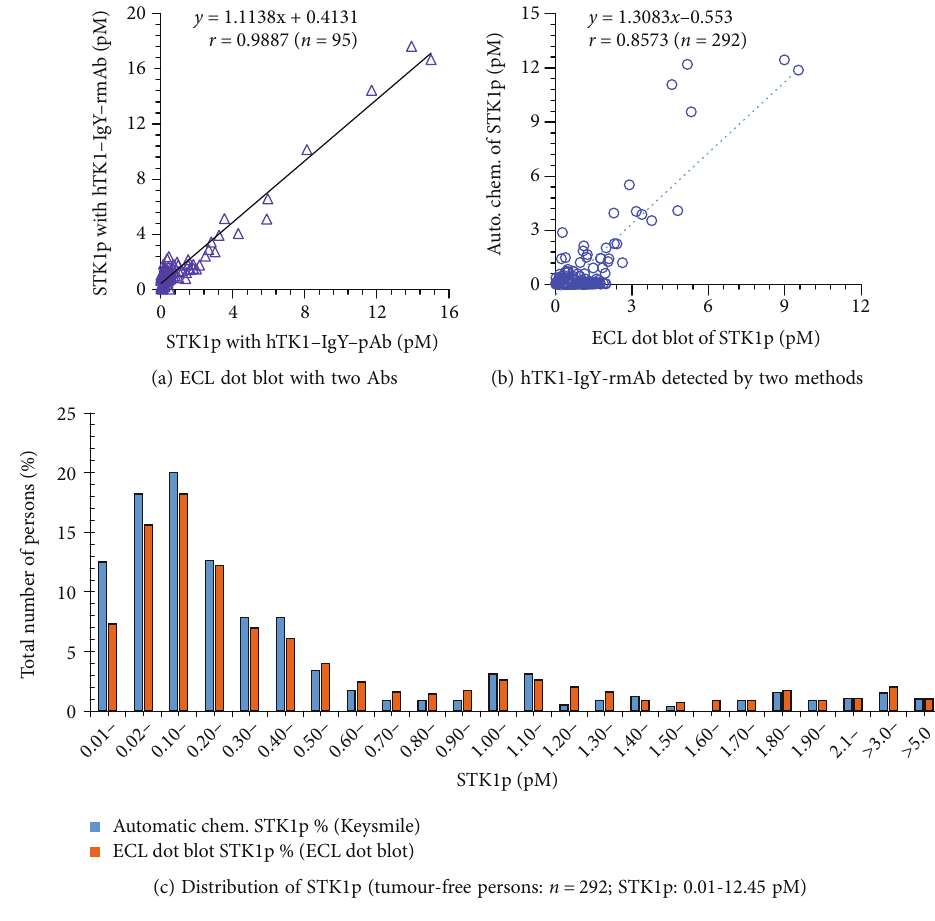
Figure 6: STK1p assay: (a) comparative study of the semiautomatic ECL dot blot assay between hTK1-IgY-pAb and hTK1-IgY-rmAb#5. Number of serum samples = 95 (STK1p, pM). (b) Comparative study of the semiautomatic ECL dot blot assay with the BSA platform and the automatic chemiluminescence analyser with the sandwich-BSA platform using hTK1-IgY-rmAb#5 (four batches). Number of serum samples = 292 (STK1p, pM). (c) Distribution of the concentration of STK1p (pM). ∗ r : Pearson correlation